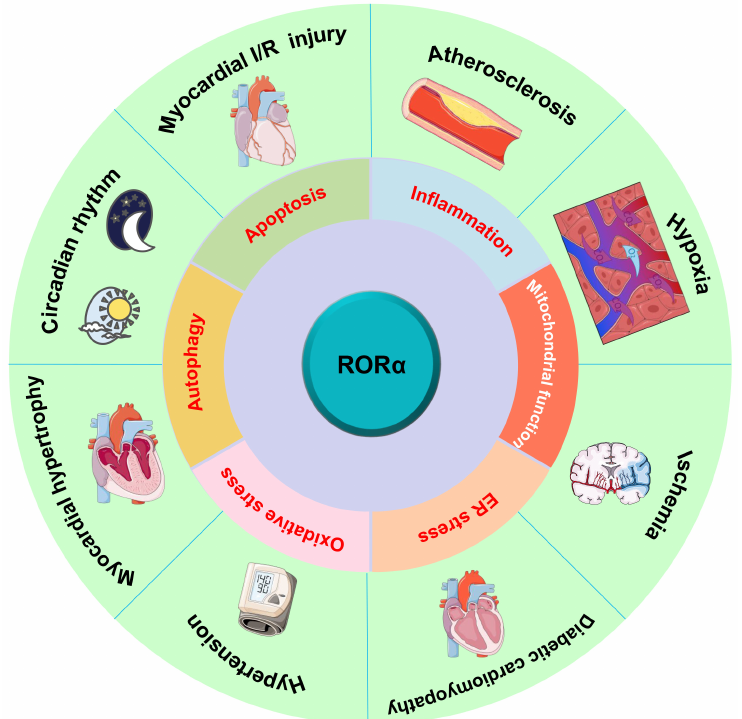
Figure 3. Potential protective effects and mechanism of ROR α on cardiovascular diseases. Besides circadian rhythm regulation, ROR α influences a wide range of physiological and pathological processes in the cardiovascular system, including atherosclerosis, hypoxia, myocardial ischemia/reperfusion (I/R) injury, diabetic cardiomyopathy (DCM), hypertension, and myocardial hypertrophy. In terms of mechanism, ROR α is involved in the regulation of inflammation, apoptosis, autophagy, oxidative stress, endoplasmic reticulum (ER) stress, and mitochondrial function.